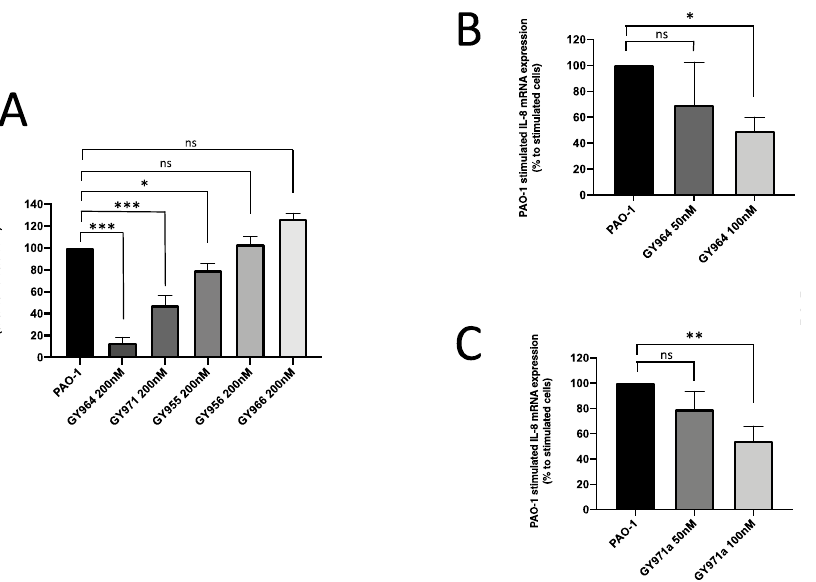
Figure 4. Effect of TMA analogues on IL-8 expression on PAO1 strain-infected IB3-1 cells. ( A ) Percent variations of IL-8 mRNA accumulation induced by 200 nM TMA analogues with respect to PAO1. ( B , C ) IL-8 mRNA quantity induced by TMA analogues GY964 (4-PhDMA) and GY971a (pANDMA) at different minor (50 and 100 nM) concentrations (mean values ± SD from three